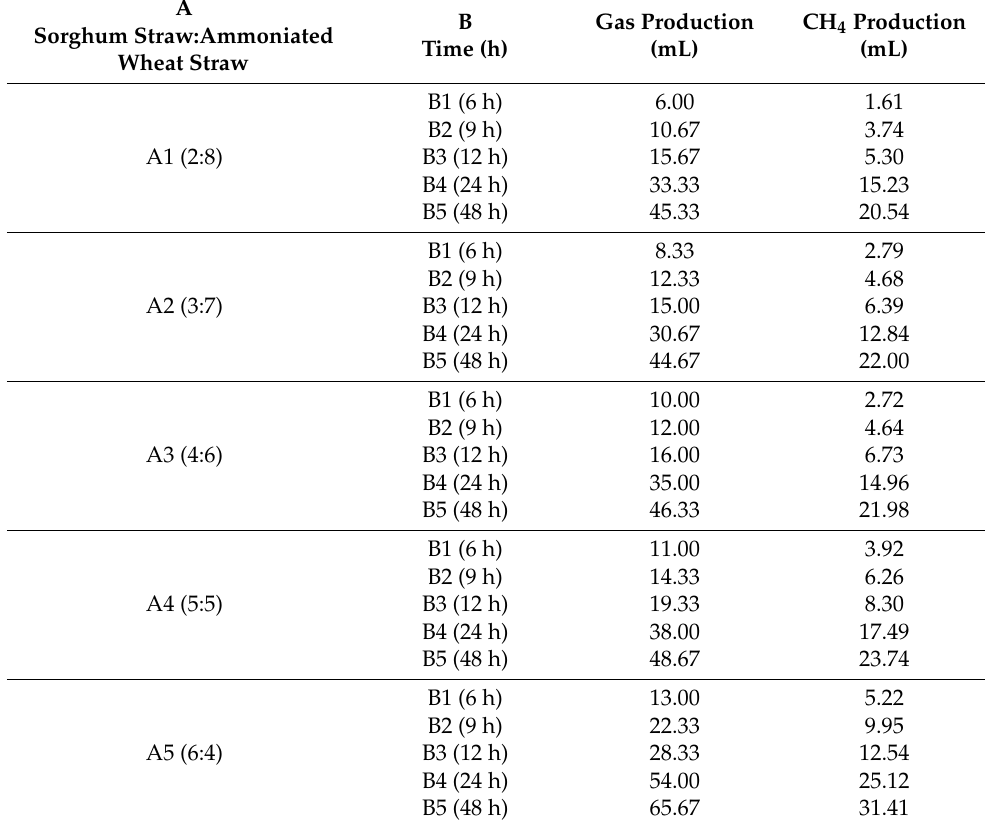
Table 6. In vitro gas production at different time